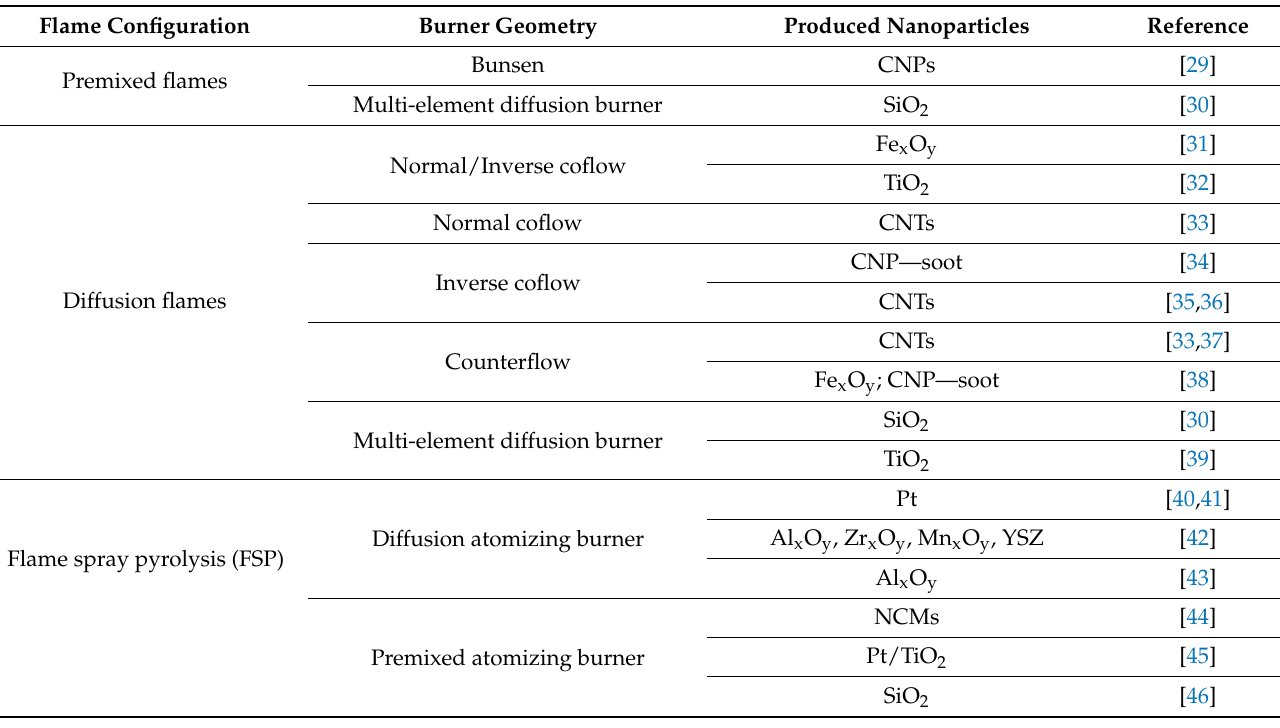
Table 1. Summary of flame configurations and the burner geometry commonly used for the study of flame synthesis of carbon and metal-oxide nanoparticles.